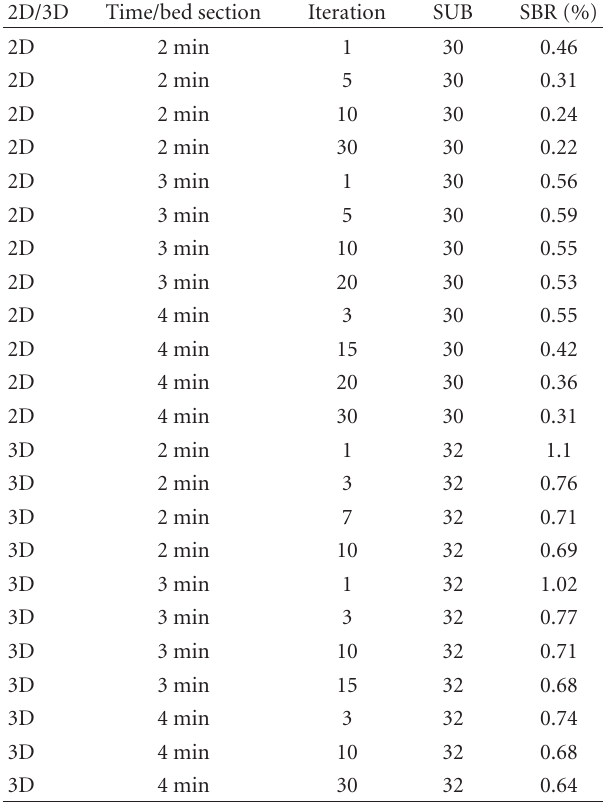
Table 4: Spheres to background ratio (SBR) for di ff erent variable